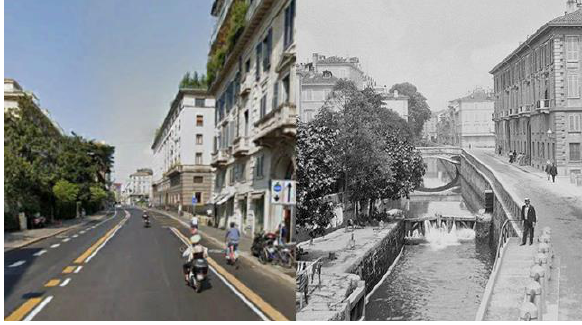
Figure 7 . Via Senato and the Senate Building, Milan. Italy: (a) today; (b) historical photos.